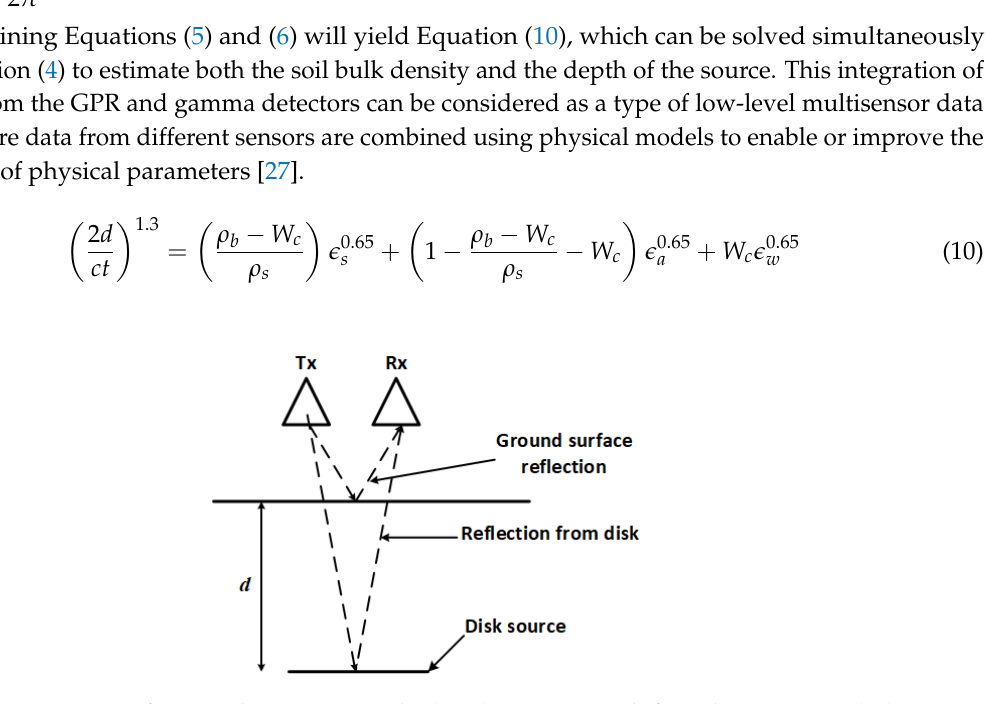
Figure 2. Operation of a ground-penetrating radar (GPR) system. Signals from the transmitter (Tx) are reflected by objects and detected by the receiver